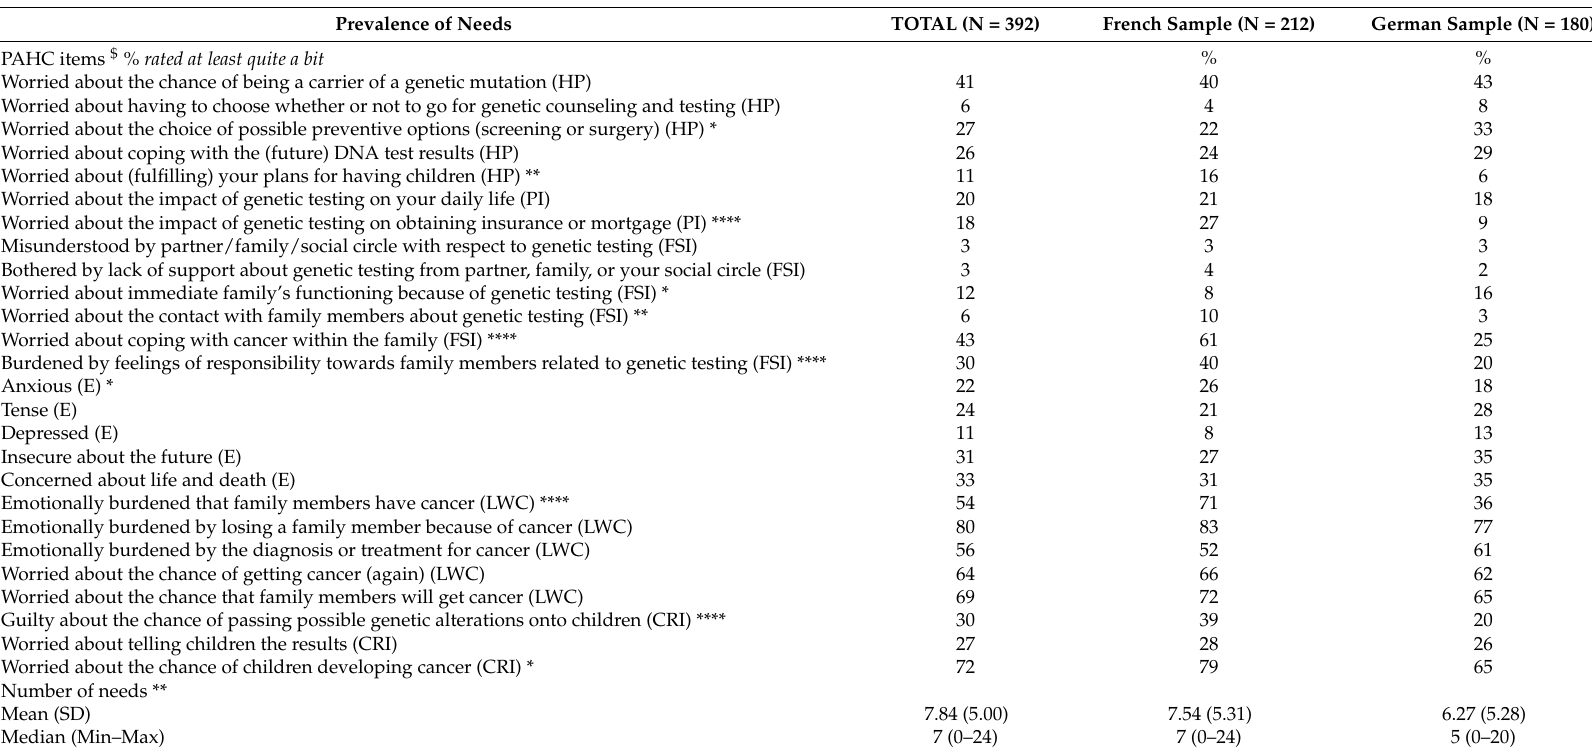
Table 2. Prevalence of participant’s responses to the Psychosocial Aspects of Hereditary Cancer (PAHC) items (% rated at least quite a bit) in the French and German study